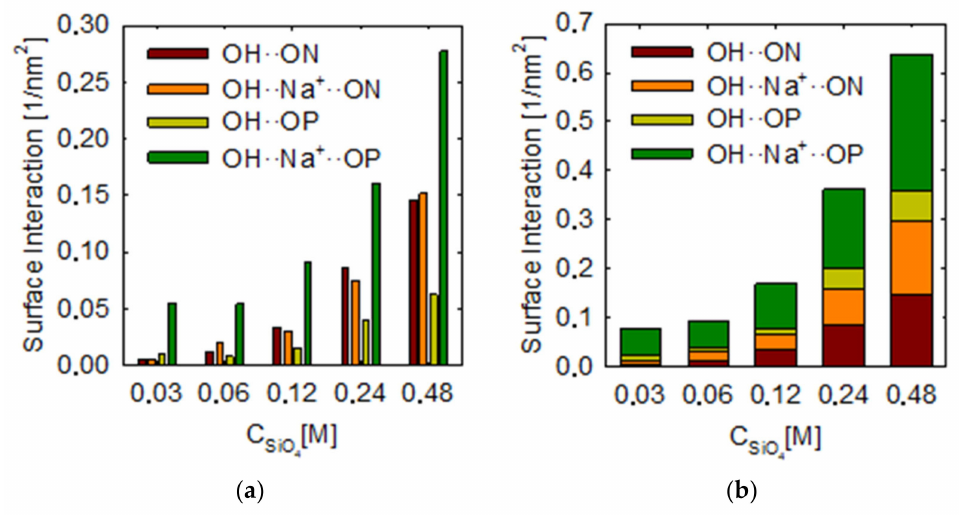
Figure 6. Mean surface interaction of metasilicate on hematite (001) surface at different metasilicate concentrations. ( a ) groups bars and ( b ) stacked